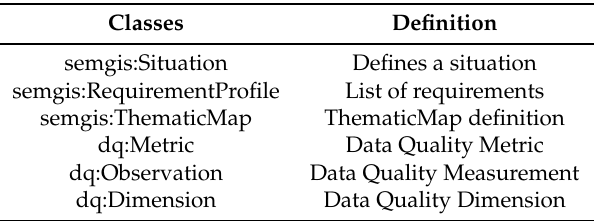
Table 1. Vocabulary Definitions for situations: Classes defining a thematic map, a requirement profile and a situation along with daQ data quality vocabulary classes are introduced.